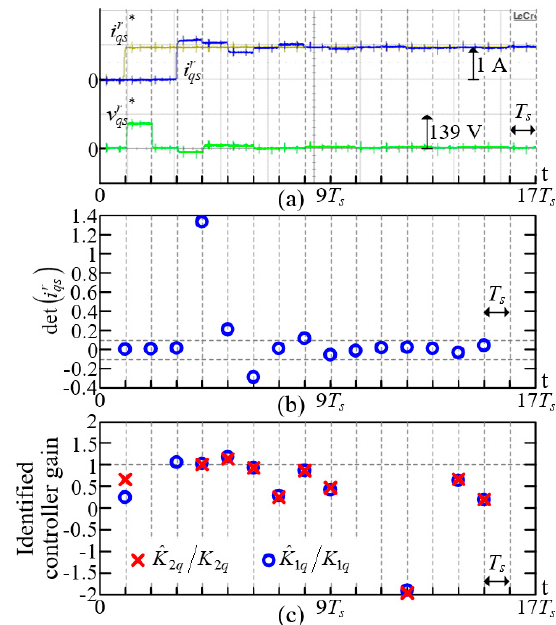
( ) r (cid:16) (cid:17) qs i det , ( c ) normalized identified controller gains. ( ) i r qs , ( c ) normalized identified controller gains. r qs i det , ( c ) normalized identified controller gains.